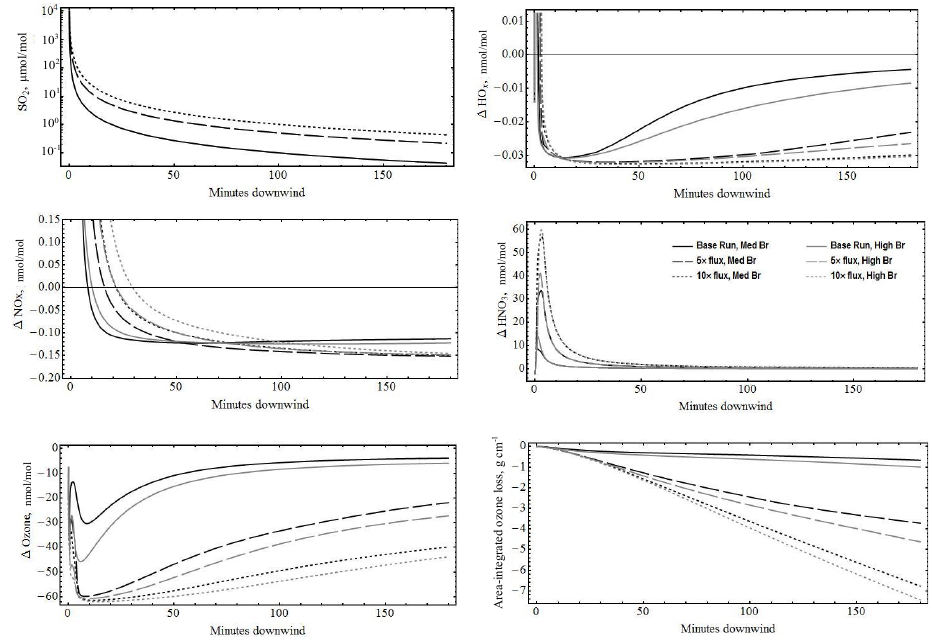
Figure 8. Simulated impact of plume BrO chemistry on atmospheric oxidants, shown for the model scenarios of Fig. 7. Depletion of oxidants and formation of NO y is shown through the difference in plume – background mixing ratio for HO x (OH + HO 2 ) , NO x (NO + NO 2 ) , HNO 3 , and ozone. Cumulative ozone loss is also calculated across the 3h